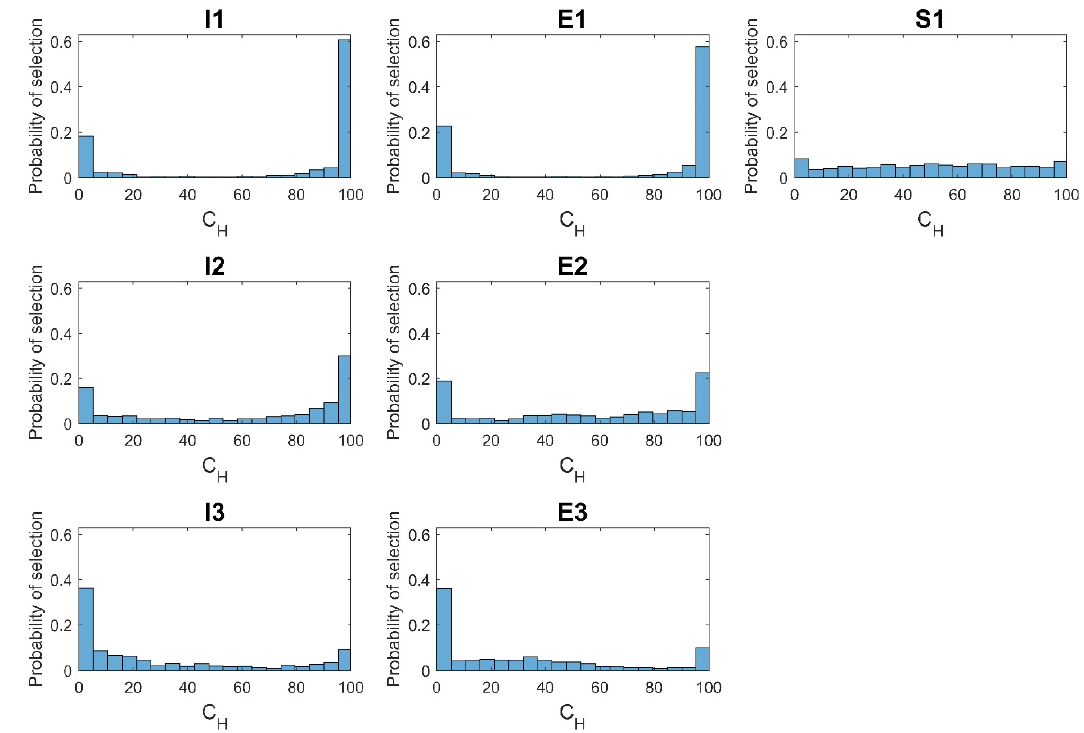
Figure 9. Probability of selection for C H values for all single turbine cases.